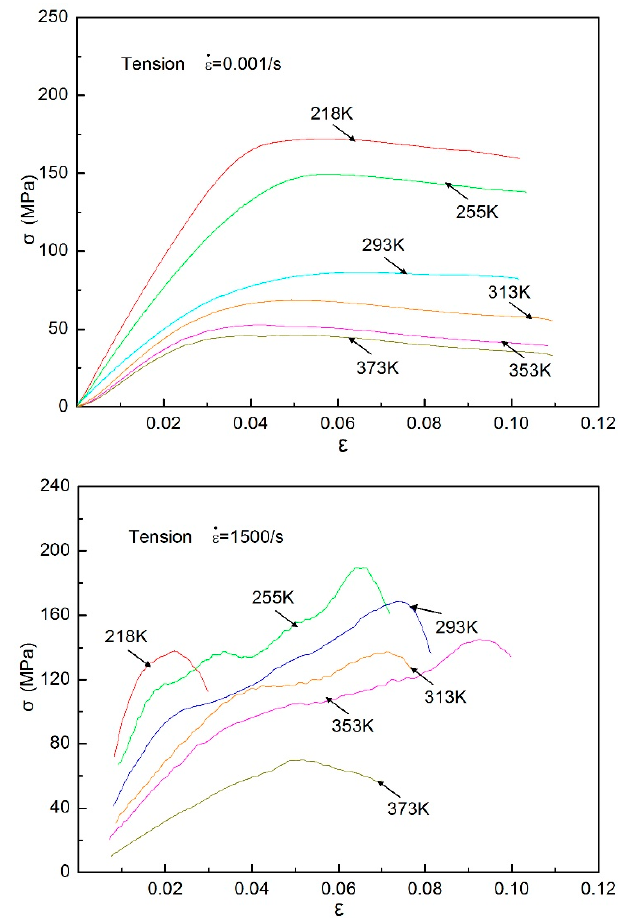
Figure 14. Quasi-static and dynamic tensile stress–strain behavior of directional polymethylmethacrylate at different temperatures.